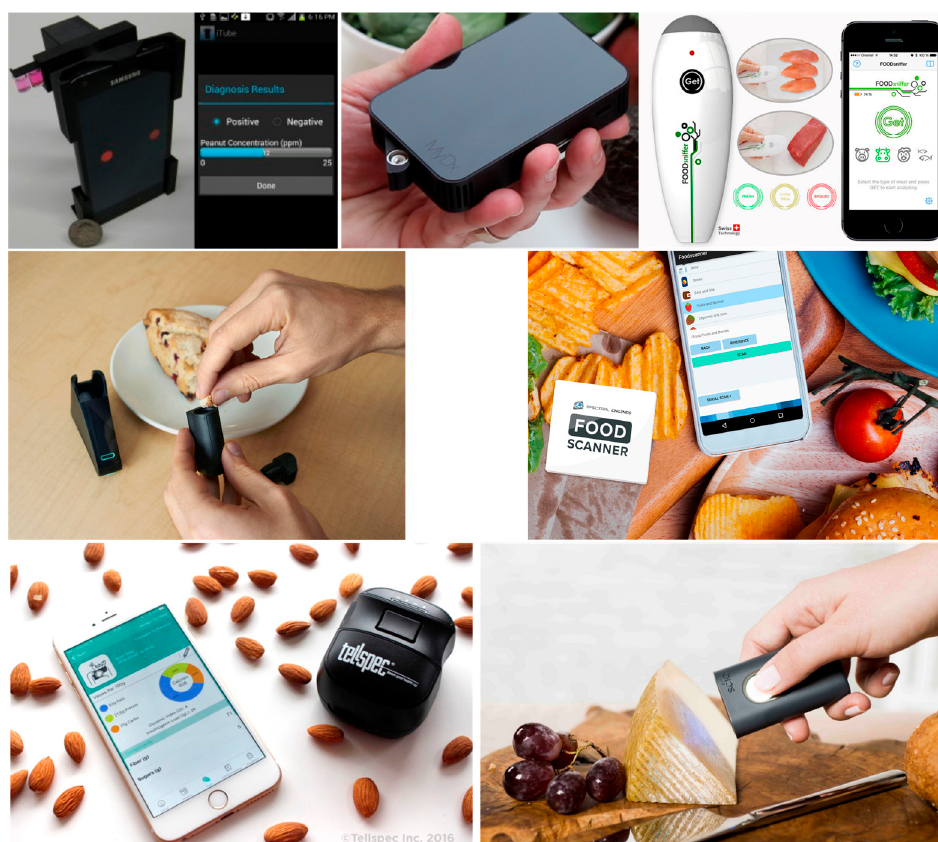
Figure 11. Commercial products for mobile food diagnostics.